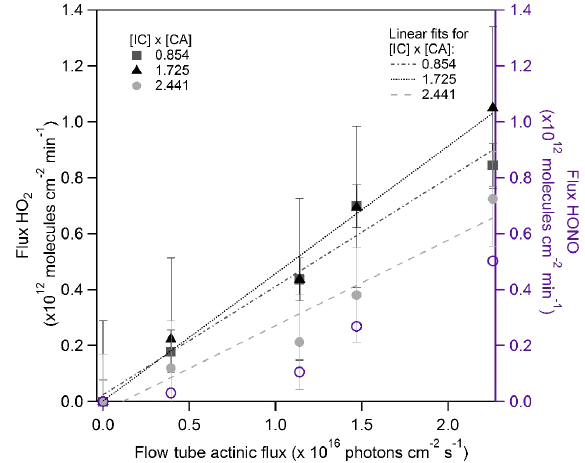
Figure 3. A linear correlation of HO 2 as a function of IC concen- tration. The left y axis represents the values for Setup 1, while the right y axis represents the values for Setup 2 (an order of magnitude difference for both scales). The Setup 2 data fall between a factor of 2 and 3 from Setup 1 after accounting for differences between Setup 1 and 2; see Sect. 3.1.1.